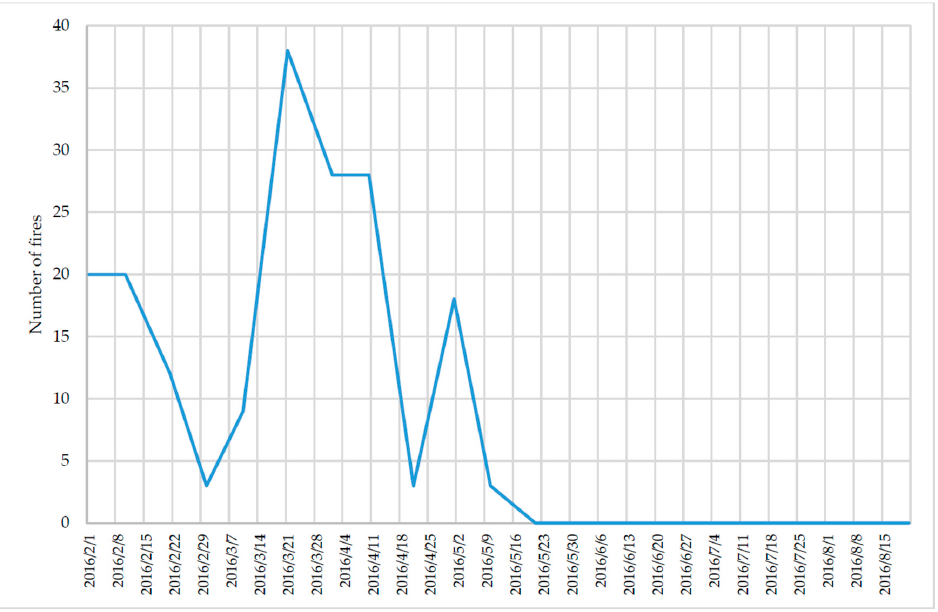
Figure 4. Number of forest fires observed in Morelos State in 2016 [22].